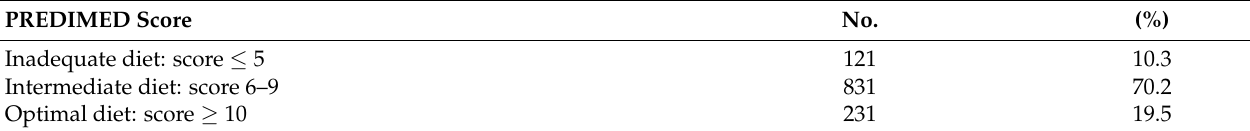
Table 1. Physical activity, sleep time, and adherence to the Mediterranean diet (indicated by PREDIMED SCORE) among students. Light activity: the heart beats just faster than normal, while exercising it is possible to speak without any problems. Moderate activity: the heart beats faster than normal, while exercising it is possible to speak but with a little trouble. Intense activity: the heart beats much faster than normal, while exercising it is difficult to speak. The “No physical activity” category includes students who do not engage in physical activity at all or practice light physical activity but not every week. The “intermediate” category includes students who practice light activity every week or moderate activity <30 min/day or <5 times/week or intense activity <20 min/day or <3 times/week. Finally, the “optimal” category includes students who practice moderate activity >30 min/day at least 5 times/week or intense activity >20 min/day at least 3 times/week. PREDIMED Score